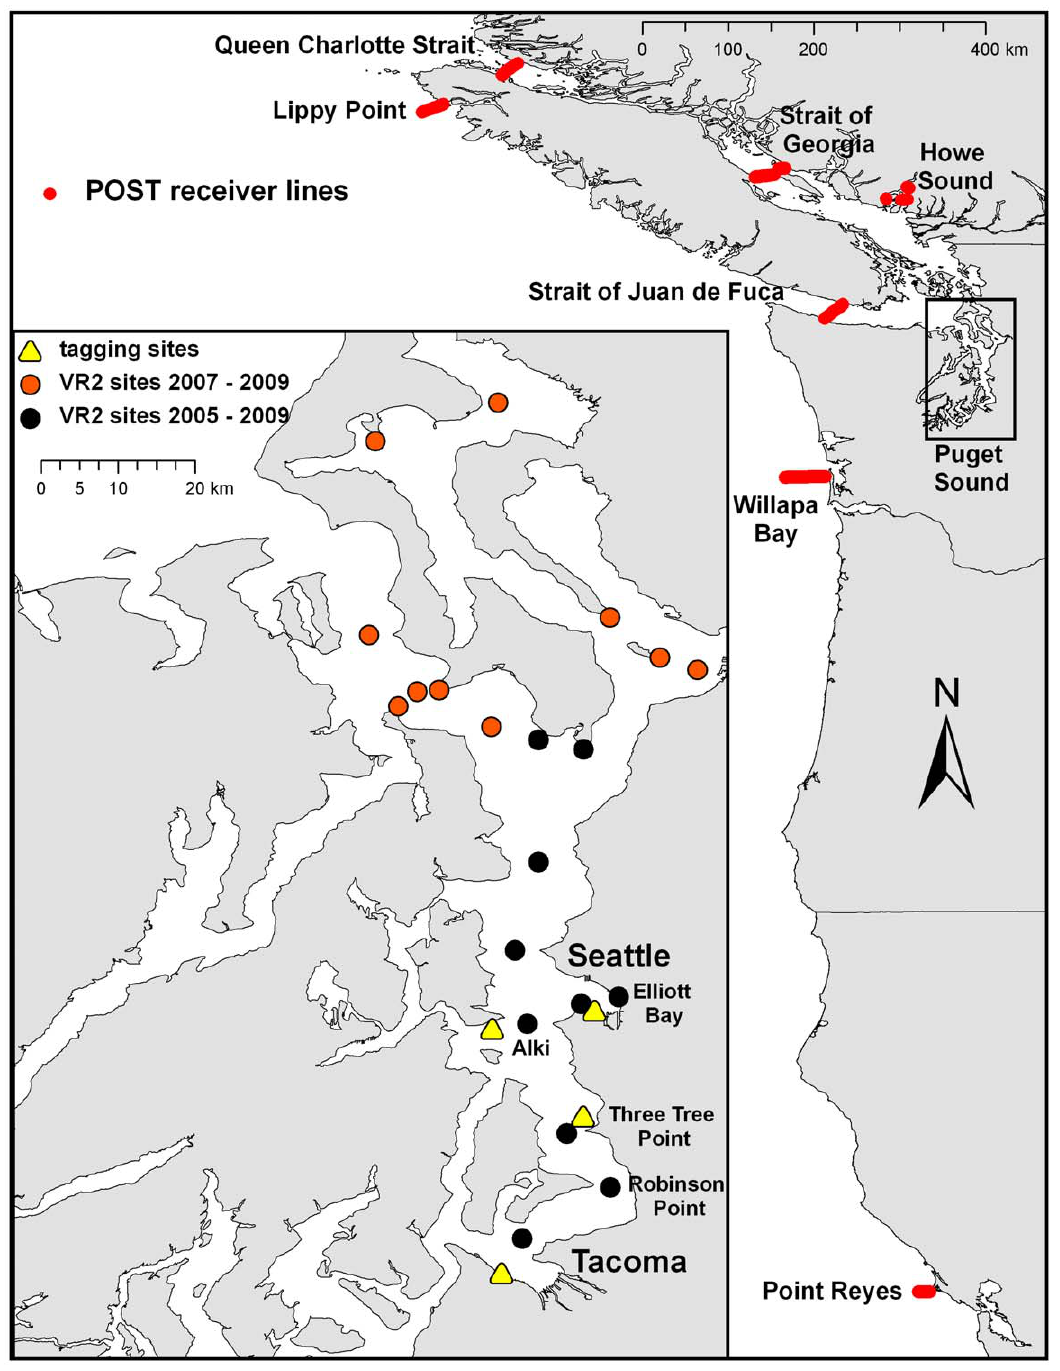
Figure 1. Locations of passive acoustic receivers from two large-scale integrated arrays. The Pacific Ocean Shelf Tracking array occurs as lines of receivers along the west coast of North America, while the inset shows the location of the primary acoustic receivers used in this study within Puget Sound, WA.